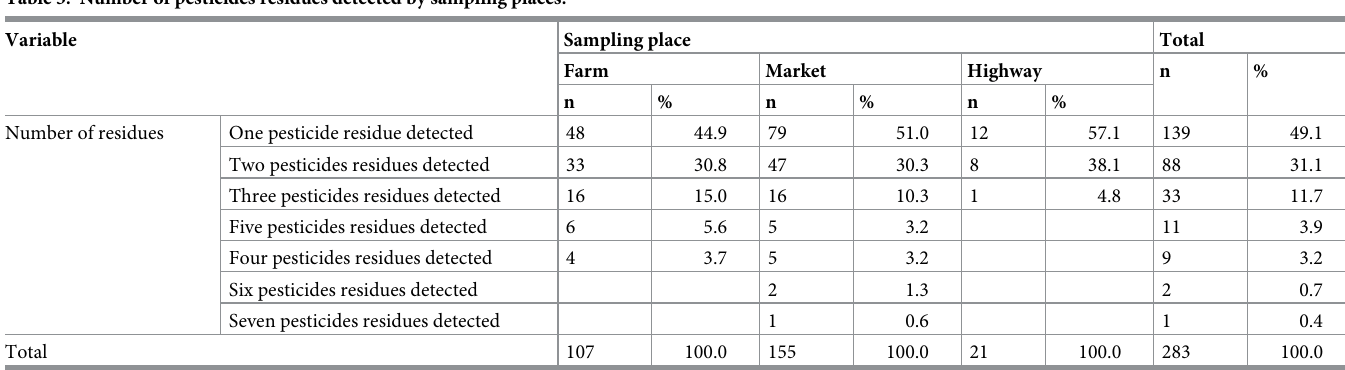
Table 3. Number of pesticides residues detected by sampling places.